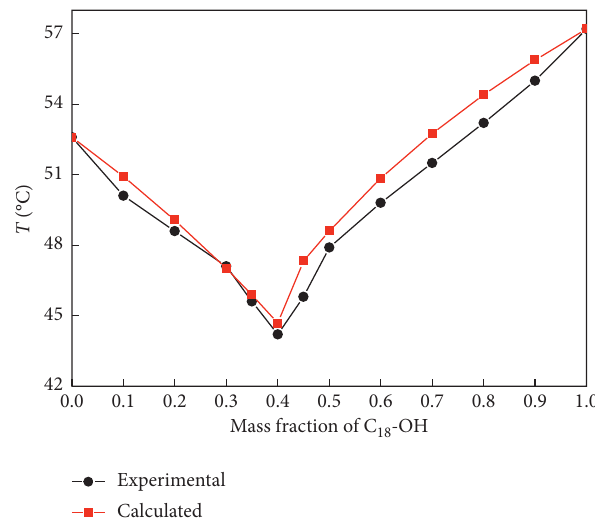
Figure 3: Comparison of phase diagrams between the calculated and experimental